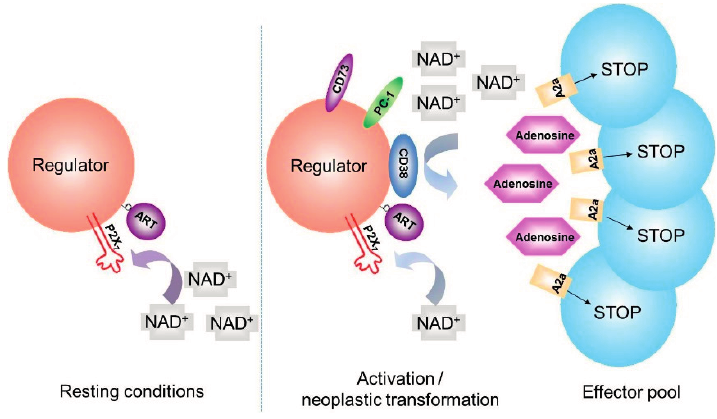
Figure 2. Hypothetical roles of CD38 in immunomodulatory and suppressor cell